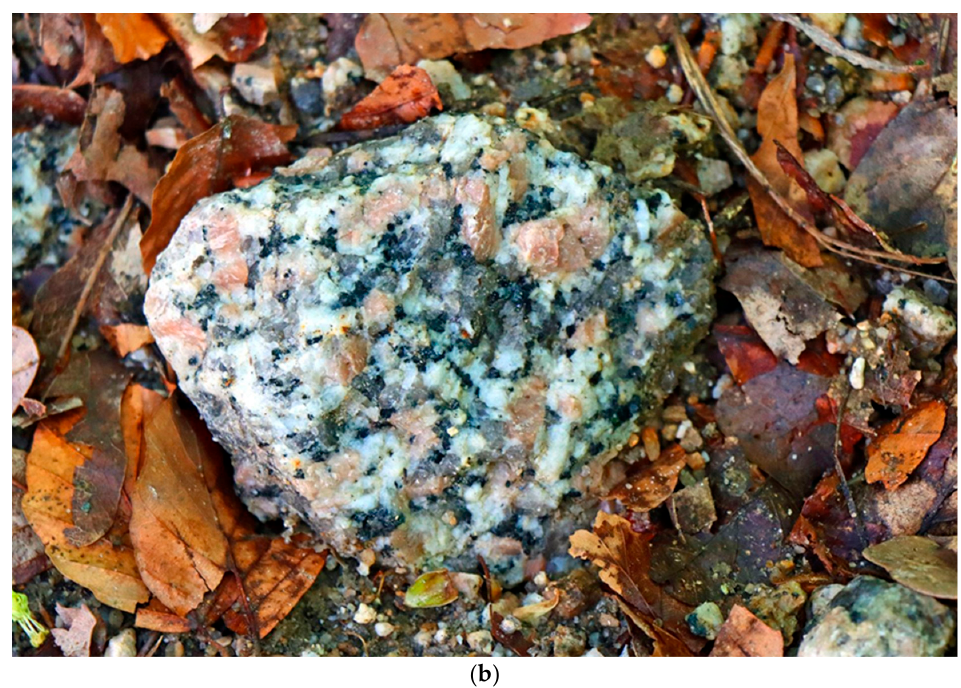
Figure 2. Liberec granite: ( a ) polished section, ( b ) fragment in nature. Photos by author. Currently, the Liberec granite rises to the surface in a long belt bordering the Jizera Mountains from the west, south and southeast [42]. The core of the Jizera Mountains consists of the Jizera granite, which is very similar to the Liberec granite. The only difference between them is that the Jizera granite has an even coarser porphyritic structure [43]. Thanks to its physical properties, the Liberec granite forms attractive rock outcrops on the surface, which are popular with hikers and climbers (see Figure 3). Many of the buildings in the region are at least partly made of Liberec granite, which thus co-creates the genius loci of these places (see Figure 4).